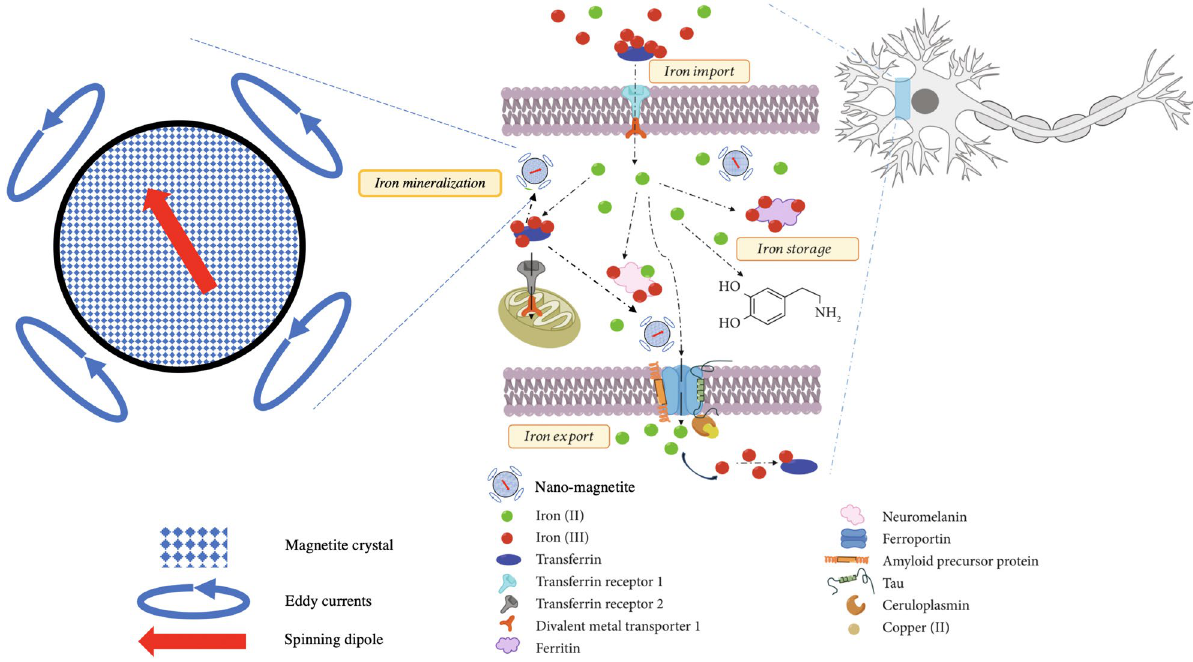
Figure 3. Iron metabolism in the neuron (modified from Abeyawardhane and Lucas (2019) 21